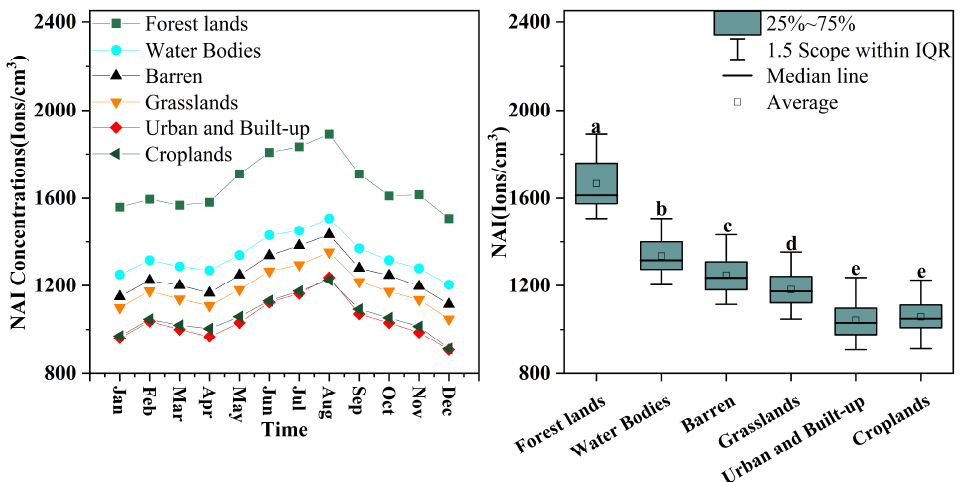
Figure 10. Intra-annual variation in NAI concentrations for different land-cover types. Different letters referred to the significant difference among the land types ( p < 0.05).